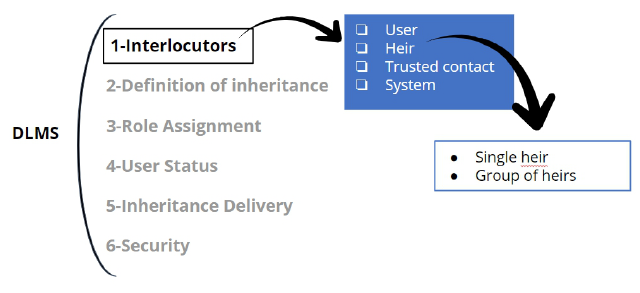
Fig. 2. Interlocutors in DiLeMa